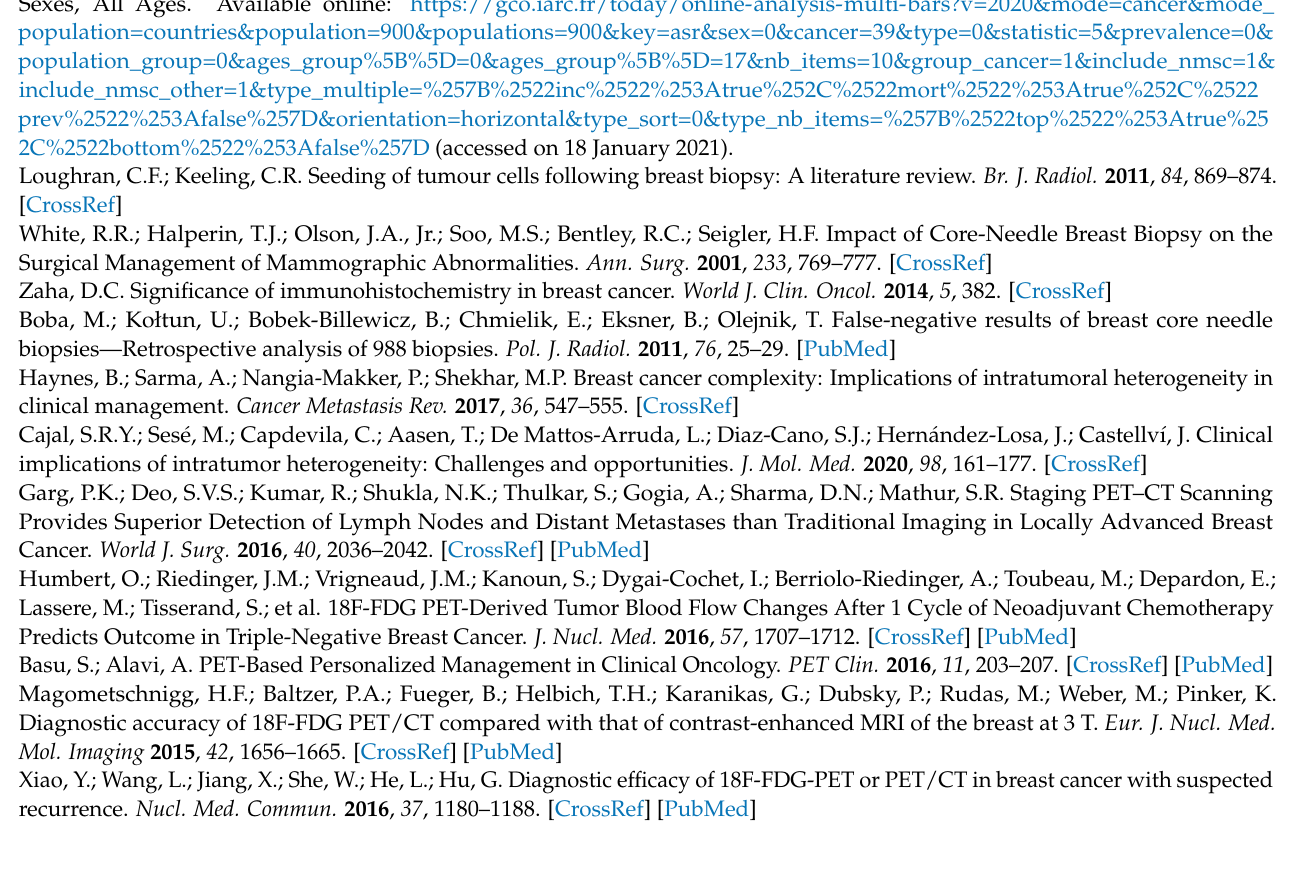
based correlation analysis, Supplemental Table S6: Holomics-based vs. standard uptake value (SUV)-based ML performance comparison across all predictive